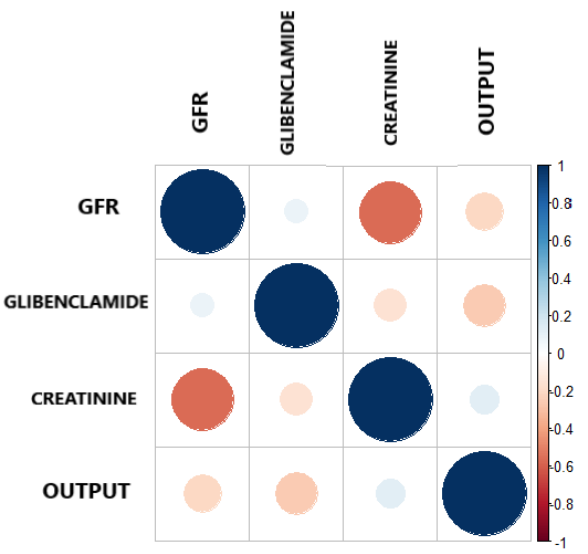
Figure 4. Correlation plot between the output and the three most important features.